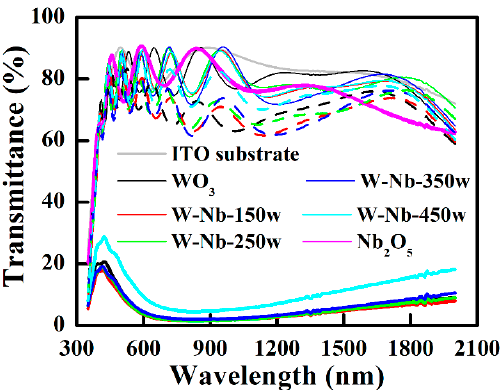
Figure 8. Spectra for the as-deposited (thin line), colored states (thick line) and bleached states (dashed line) of WO 3 , WO 3 –Nb 2 O 5 , and Nb 2 O 5 films deposited on ITO coated B270 glass